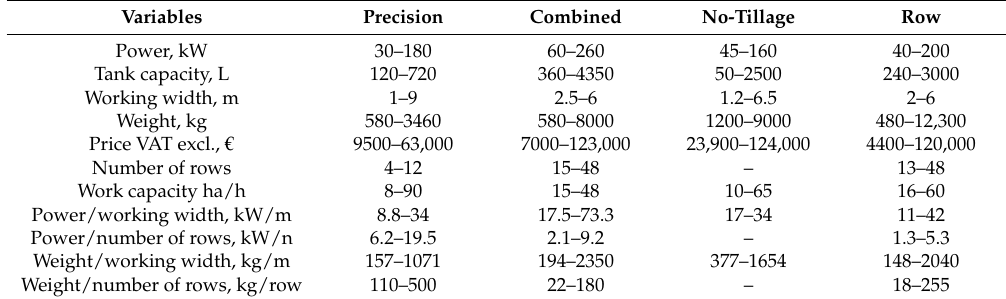
Table 2. The range for minimum and maximum values of the considered variables according to the